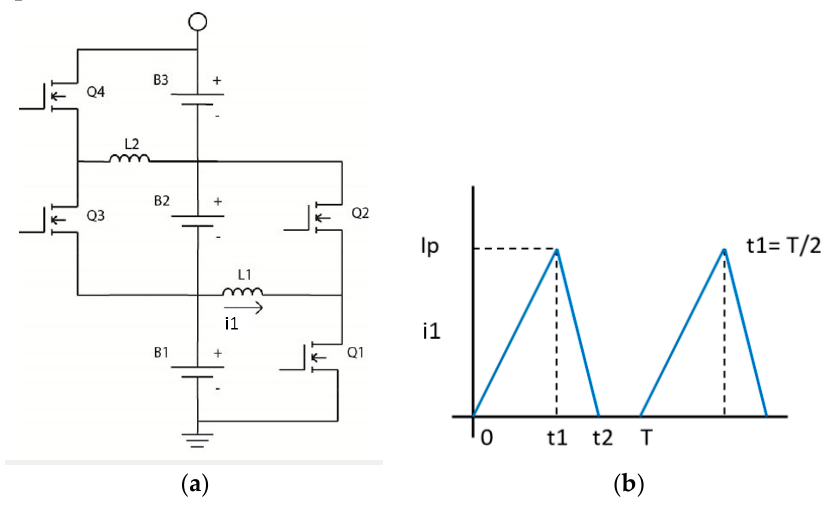
Figure 2. Active equalizer (AEQ) ( a ) Schematic; ( b ) Current in L1.